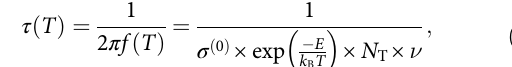
T . Figure 3e, f present the temperature dependence of the characteristic frequencies f α and f β , in the coordinates log( f ) vs 1000/ T that re fl ect the form of Eq. (2). Qualitatively, f α ≃ 4 Hz exhibits no observable change as a function of temperature. In contrast, the evolution of f β indicates an exponential decrease upon cooling; such an exponential temperature dependence has been previously reported in tunneling junctions where the electron velocity is independent of temperature 23,24 .